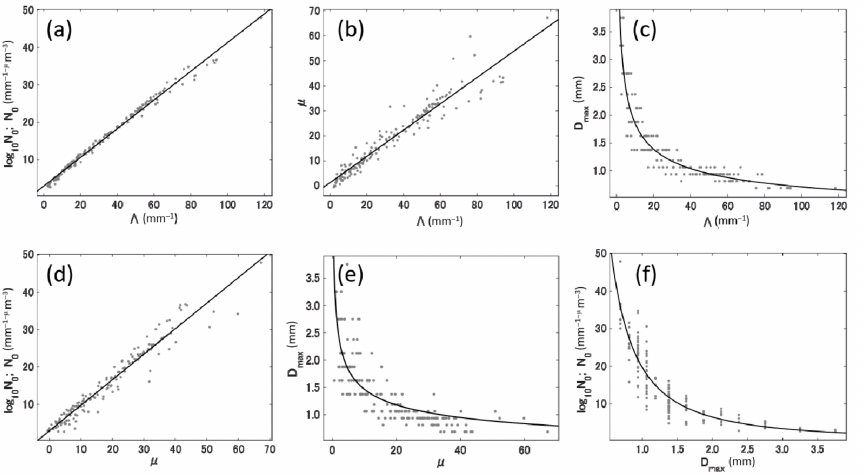
Figure 9. Scatter plots of gamma PSD parameters: ( a ) Λ vs. log 10 N 0 , ( b ) Λ vs. µ , ( c ) Λ vs. D max , ( d ) µ vs. log 10 N 0 , ( e ) µ vs. D max , and ( f ) D max vs. log 10 N 0 .